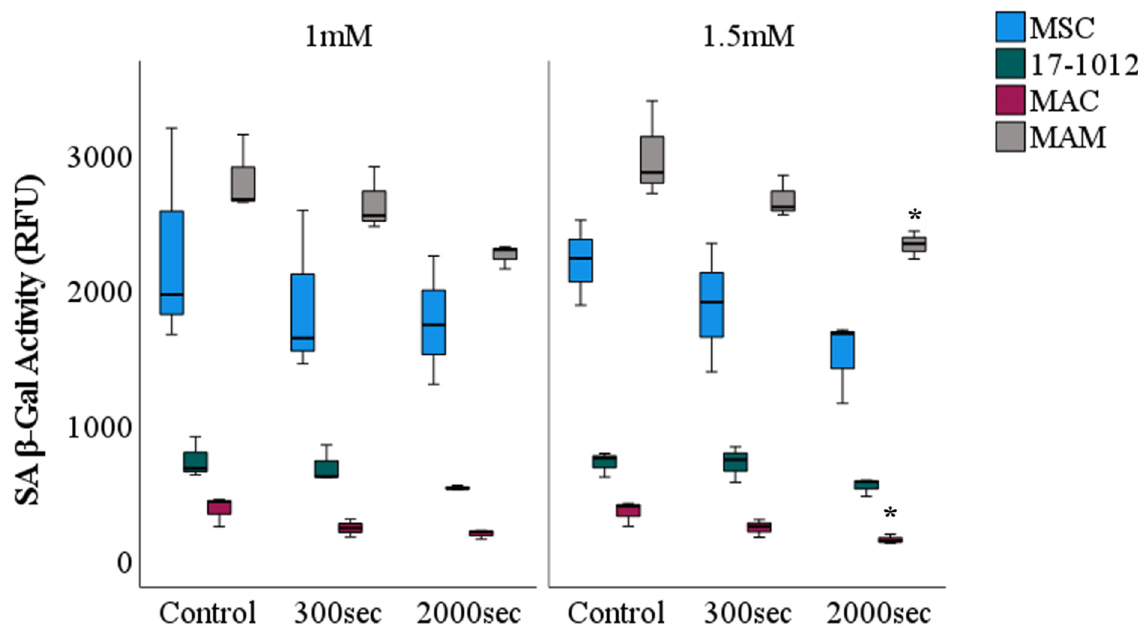
Figure 5. Cellular senescence (SA β -Gal Activity ) assessment of bone metastasis cell lines after PDT exposure . All cell lines (17-1012—giant cell tumor of bone, MAC—bone metastases of invasive ductal breast carcinoma, MAM—bone metastases of renal cell carcinoma, and MSC as a control) were subjected to PDT exposure for predefined time frames of either 300 sec or 2000 sec. As a photosensitizer, 5-ALA was employed at two different concentrations: 1 mM (left side) and 1.5 mM (right side). Comparisons were conducted in relation to the control group (cells that were not subjected to PDT exposure). Data of 3 experiments performed in triplicates. * p < 0.05. Abbreviations: 5-ALA—5-aminolaevulinic acid, RFU—relative fluorescence units, sec—seconds.